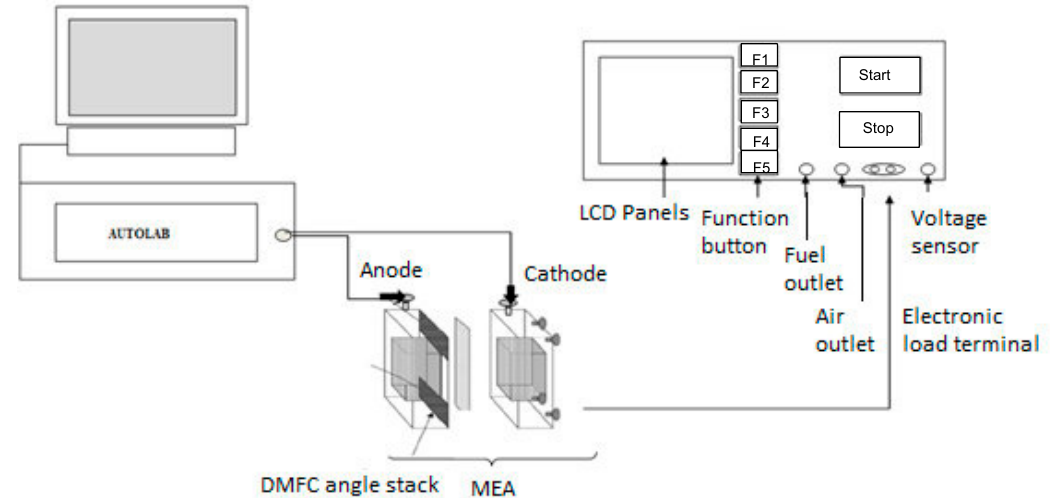
Figure 2. The schematic diagram of fuel cell analyzer test system. DMFC: direct methanol fuel cell; MEA: Membrane Electrode Assembly.